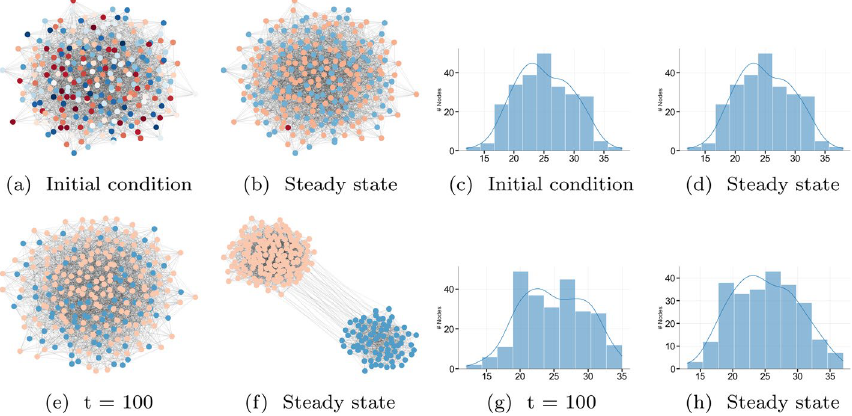
Fig. 6 Example of the effects of the adaptive topology on the Adaptive Algorithmic Bias Model on the Erdős–Rényi graph with γ = 0.5 . An example of the effects of the co-evolution of network structure and opinions in the Adaptive Algorithmic Bias model on the Erdős–Rényi graph for ǫ = 0.2 , p r ∈ { 0.0,0.5 } and γ =